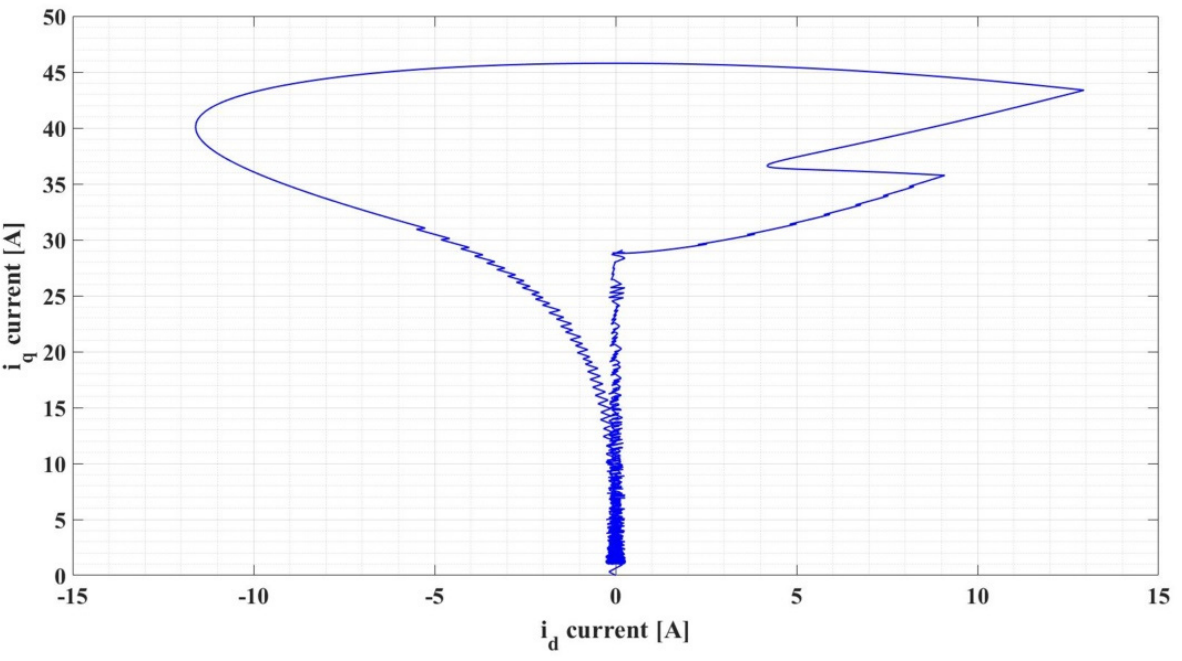
Figure 26. Image of the phase plan for PMSM variable structure with switching signal type 2: i q current versus i d current ( ω ref = 800 rpm).